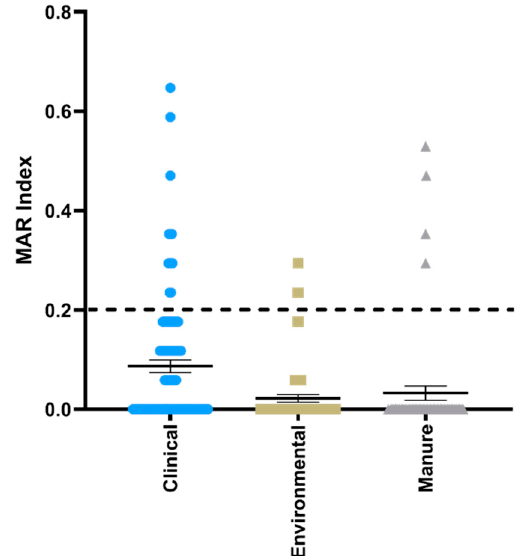
Figure 2. Multiple antibiotic resistance index (MAR) of clinical, environmental, and manure E. coli isolates. Isolates are presented as individual values with the mean and standard error of each source plotted. MAR indices >0.2 indicate that isolates likely originate from areas of high antibiotic use or a high risk source [30].